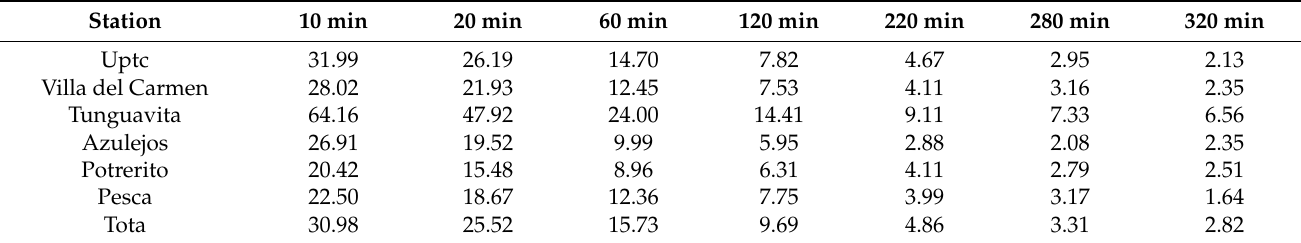
Table 1. Intensity (mm/h) of the precipitation for two years at different